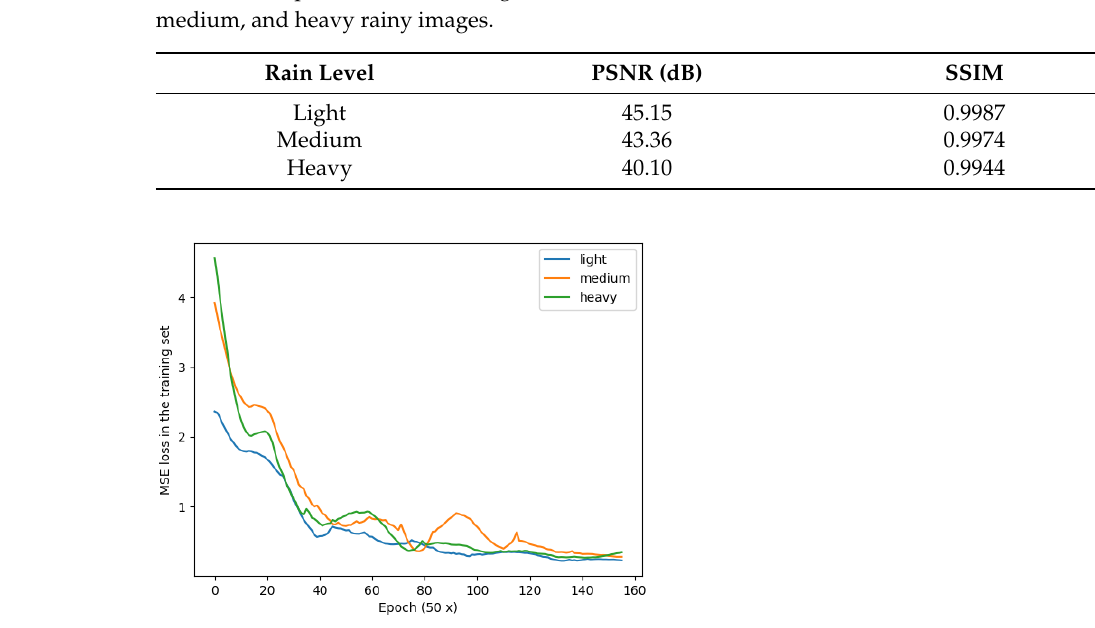
Figure 8. Curves of L DR on the training set for light, medium, and heavy rainy images.